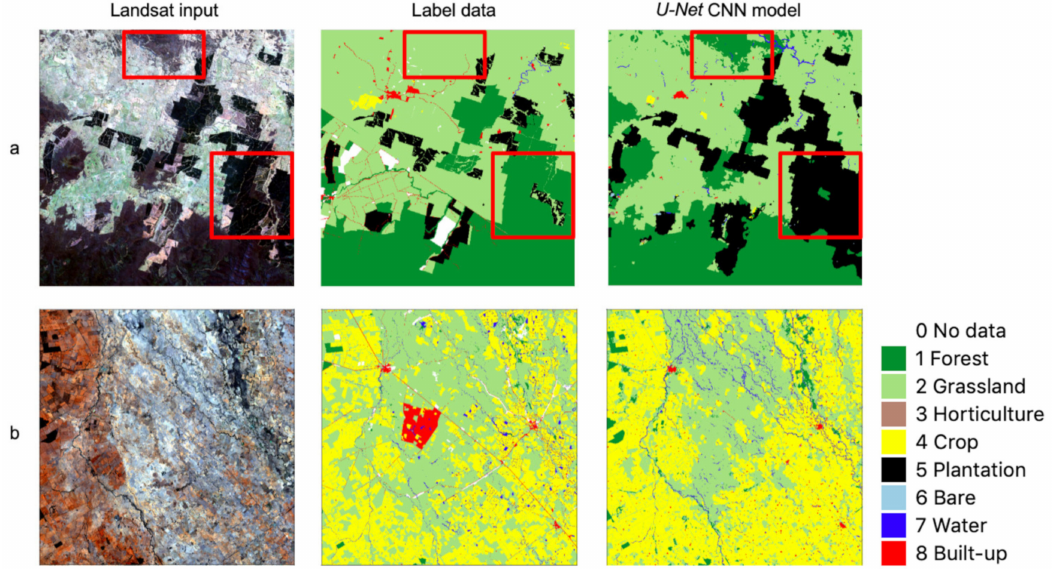
Figure 7. ( a ) Landsat input (true colour RGB), label data and U-Net CNN model for area (~26.5 km × 26.5 km) centred at 37.10 ◦ S, 149.01 ◦ E. ( b ) Results for tile +14, − 36 (~100 km × 100